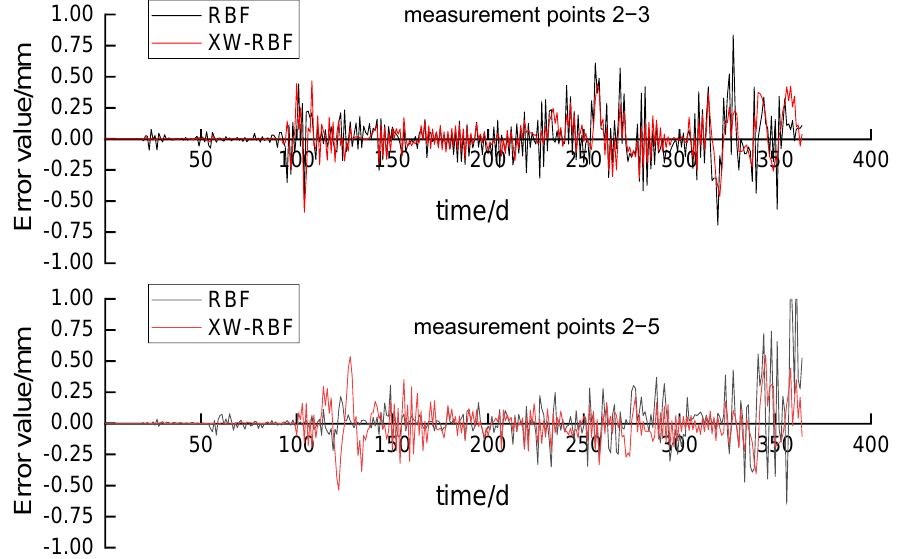
Figure 10. Error Analysis of Comparison between New Predicted Value and Measured Value.